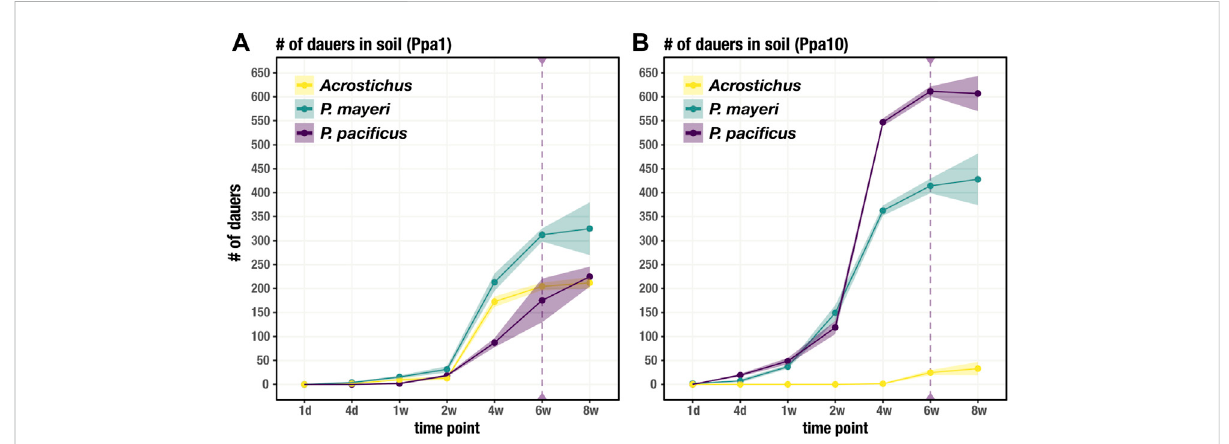
Dauer dispersal from the carcass to soil. Soil includes the soil immediately surrounding the carcass (in the carcass compartment) and the soil in therestofthecage.Numberofdauersfoundoutsideofthecarcassforeachspeciesover8 weeksonPpa1 (A) andPpa10 (B) .Dottedpurplelineatt= 6 weeks de fi nes when P. paci fi cus was fi rst found in soil outside of the carcass compartment, not just the carcass soil in the carcass compartment. N = 3 cages per time point (except t = 8 weeks, where n = 2 cages), with the average numbers shown. Ribbons indicate standard error of the